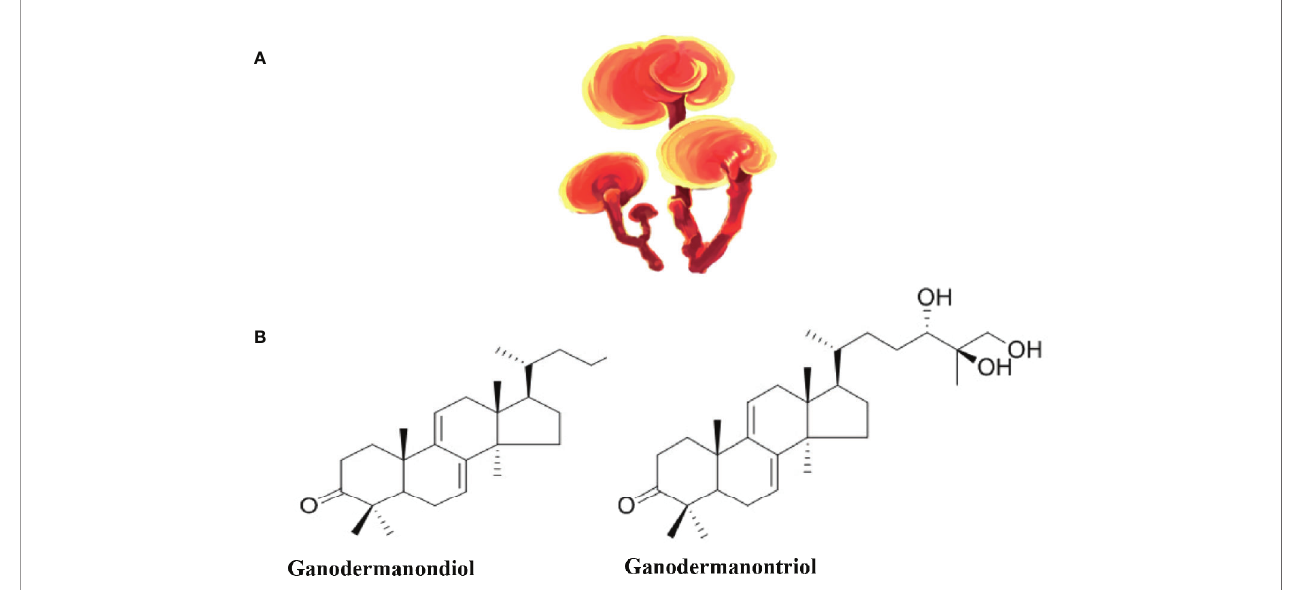
FIGURE 4 | Ganoderma lucidum . (A) Ganoderma lucidum (from https://pngtree.com/freepng). (B) Examples of the chemical structure of two Triterpenes from Ganoderma lucidum